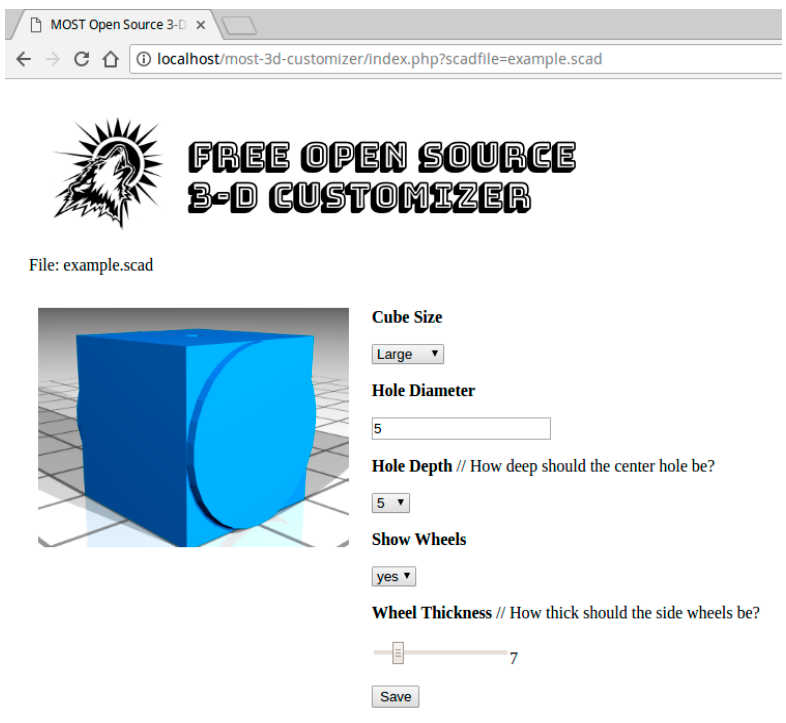
Figure 3. The parameters were adjusted on the Free Open Source 3-D Customizer page to create a new design.